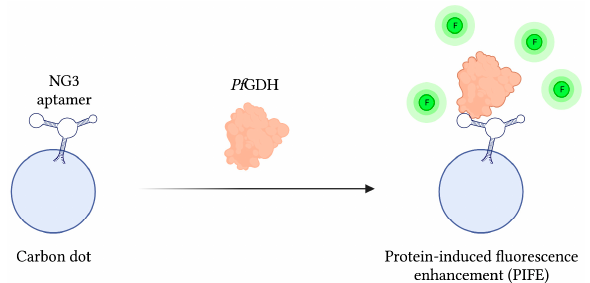
Figure 5. The schematic illustration of the Fluorescence-based aptasensor for Plasmodium falciparum GDH detection described by Singh et al. [111]. The fluorescence intensity (F) of the carbon dot-aptamer assembly is enhanced by their interaction with Pf GDH. Adapted with permission from Ref. [111]. 2018, American Chemical Society. Created with BioRender.com (accessed on 19 December 2021).